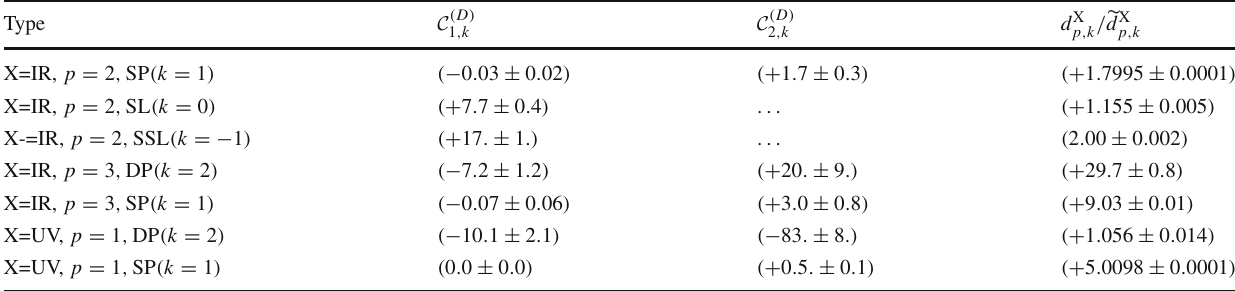
Table 1 The coefficients C ( D ) renormalons, and D = − 2 p for UV